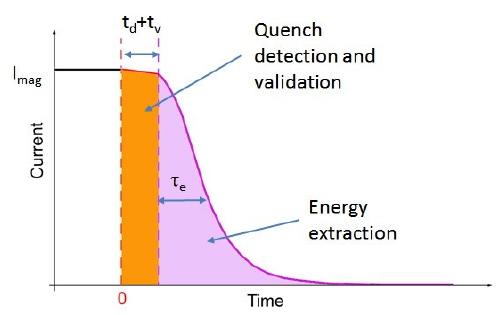
Figure 4. A typical energy extraction timeline and its characteristic time for an accelerator magnet.